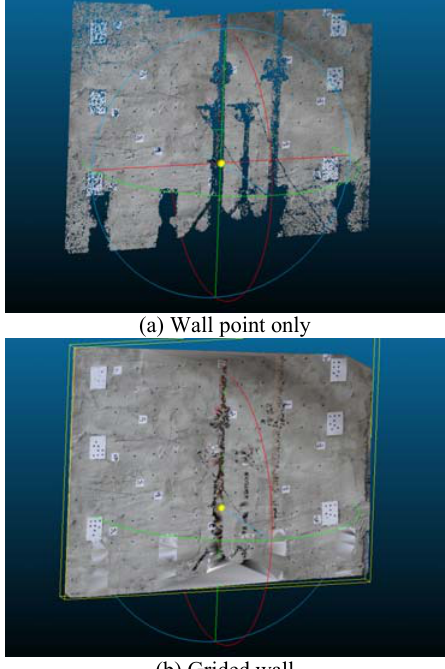
Figure 4. Filtering and